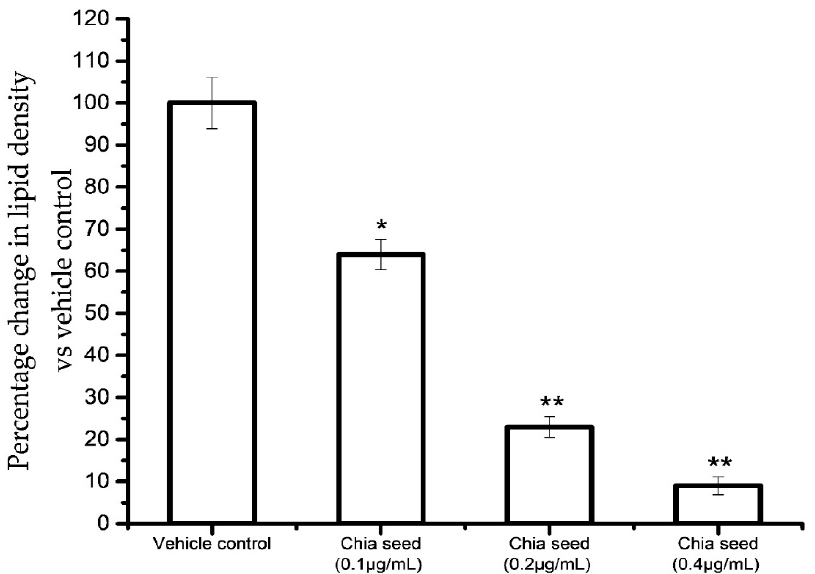
Figure 4. Relative density of oil red O extracted from chia seed fatty acid treated maturing adipocytes after 14 days. Data are expressed as the mean ± S.E.M. ( n = 6). * p < 0.05 and ** p < 0.001 vs. vehicle control. Table 3. Effect of chia seed fatty acid extract on triglyceride, free glycerol, high density lipoprotein (HDL), low density lipoprotein (LDL) levels and lactate dehydrogenase (LDH) activity in matured adipocytes after 14 days.